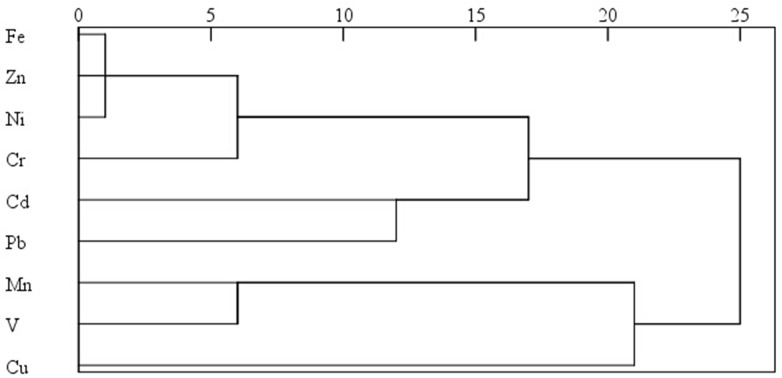
Dendogram of heavy metal concentrations in foliar dusts of Panzhihua.